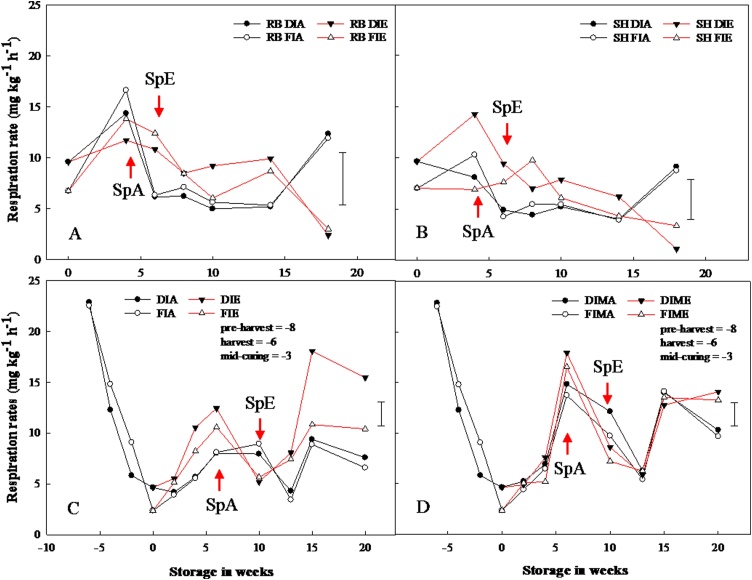
Real-time respiration rates as CO2 production (mg kg–1 h–1) of stored onion bulbs. Onion bulbs of cultivar ‘Red Baron’ (RB) and ‘Sherpa’ (SH) were grown in 2015 (A and B) and ‘Sherpa’ in 2016 (C and D) under full irrigation (FI) or deficit irrigation (DI); where FI amounted to 100% replenishment of crop evapotranspiration (ETc) and DI was ETc replenishment at 50%. Bulbs were harvested at full maturity (100% fall-down) and cured under glass for six weeks for both years. Post-curing, bulbs were treated with or without 1-MCP at 1 μL L−1 for 24 h before storage; and then, stored at 1 °C under continuous ethylene supplementation at 10 μL L−1 or air. DIA and FIA are DI and FI bulbs in air, DIE and FIE are DI and FI bulbs stored under ethylene, DIMA and FIMA are DI and FI bulbs treated with 1-MCP and stored in air and DIME and FIME are DI and FI bulbs treated with 1-MCP and stored under ethylene. SpA and SpE are sprout emergences for bulbs stored in air and ethylene, respectively. LSD bar at 95% confidence shown.